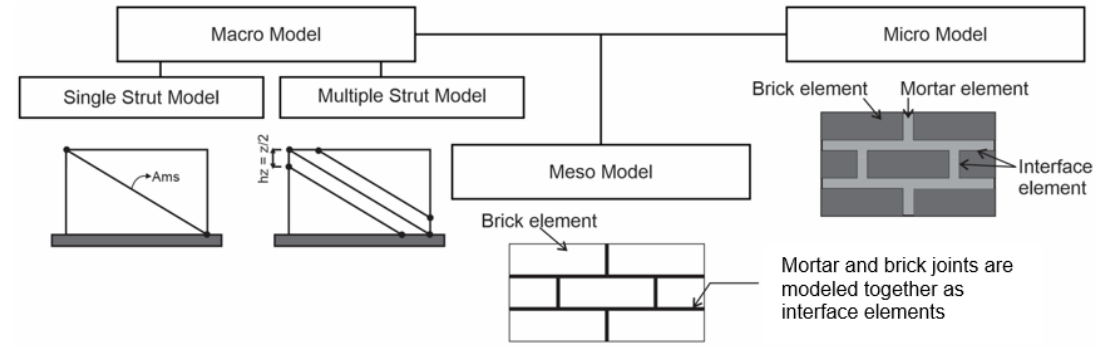
Figure 1. Developed infill frame modeling technique